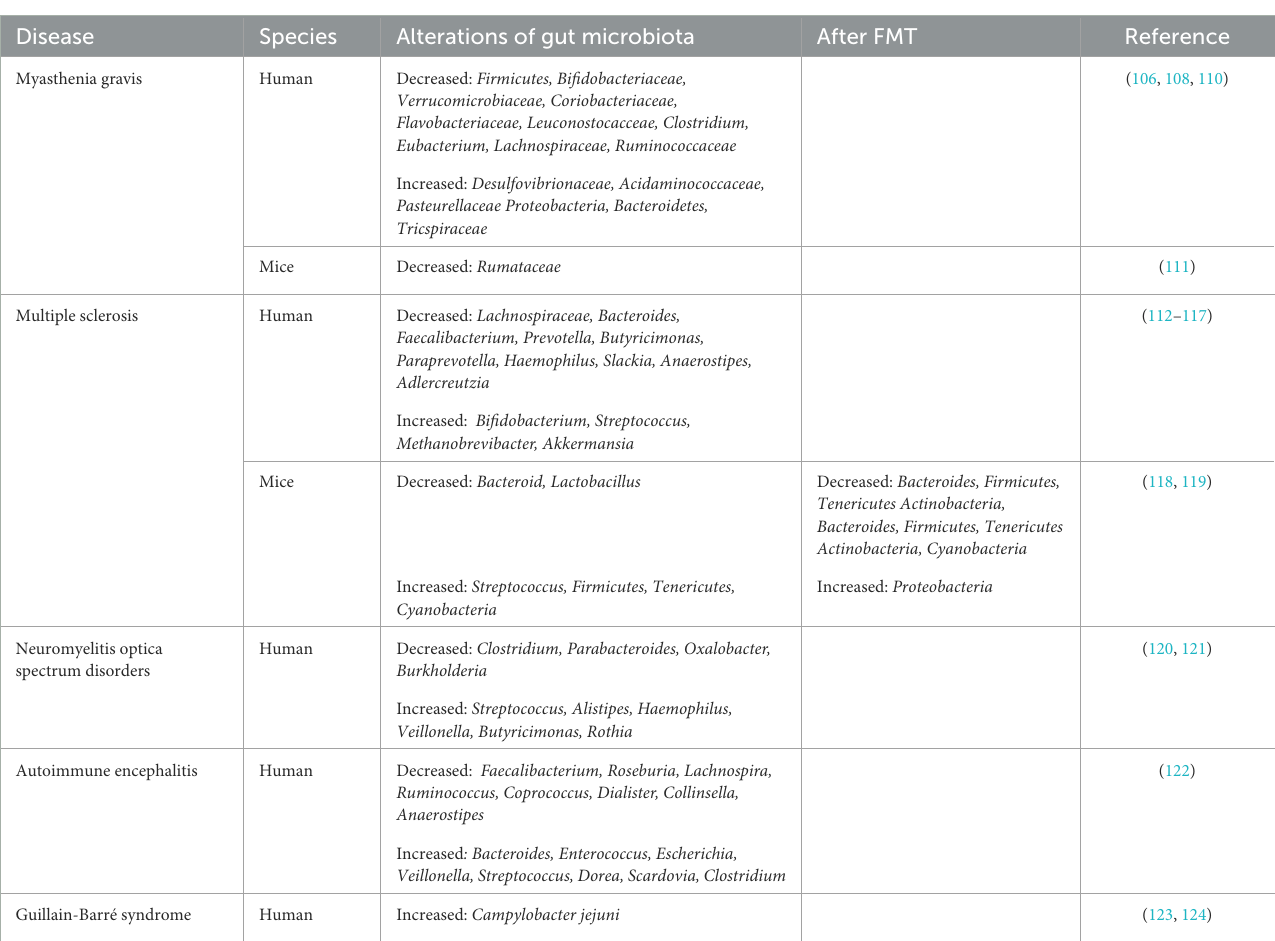
TABLE 1 The alterations of gut microbiota in neuroimmune